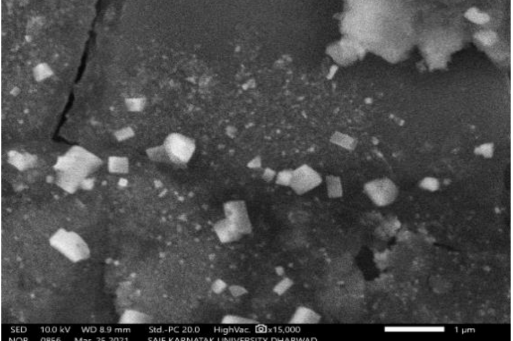
Figure 4. SEM image of PGAg nanoparticles viewed at × 15,000 magnifications with an 8.8 mm scale.